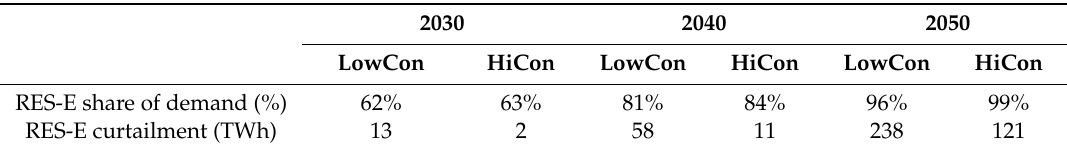
Table 1. RES-E share and curtailment in the ENTSO-E